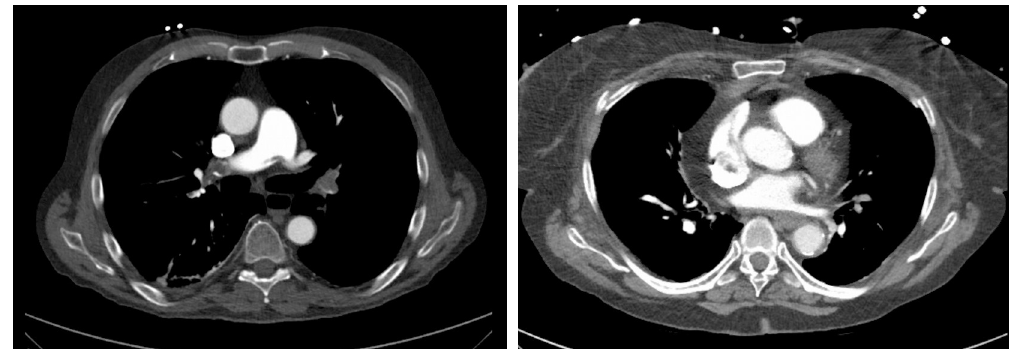
Fig 1. Representative patients of the patient sample. a . 79-years old male patient with massive acute pulmonary embolism. A saddle thrombus of the pulmonary trunk can be appreciated. The Mastora score was for reader 1 109, for reader 2 75, the Qanadli for reader 1 50, for reader 2 40, Ghanima score was 4 for both readers and Kirchner score was 12.25 for reader 1 and 11 for reader 2. The time duration was longest for Mastora score for both readers, 463 s and 281 s, followed by Qanadli 53 and 35 s, Kirchner 36 s and 167 s and the Ghanima with 13 and 6 s. b . 84-years old female patient with segmental acute pulmonary embolism of the lower lobes. The Mastora score was for reader 1 45, for reader 2 29, the Qanadli for reader 1 22.5, for reader 2 20, Ghanima score was 2 for both readers and Kirchner score was 3 for both readers. The time duration was longest for Mastora score for both readers, 187 s and 151 s, followed by Qanadli 150 and 34 s, Kirchner 92 s and 32 s and the Ghanima with 26 and 9 s.